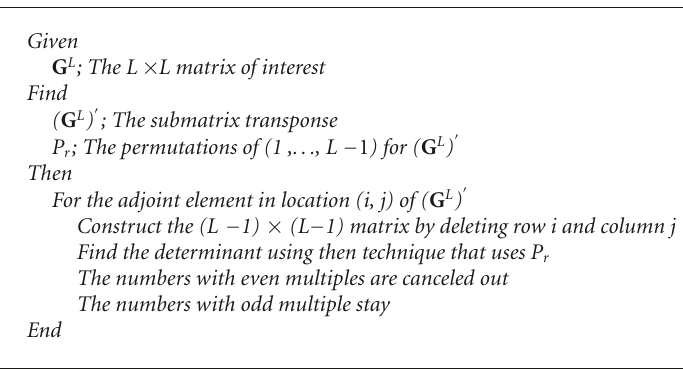
Algorithm 1: A routine to find the adjoint matrix using the permutation technique.